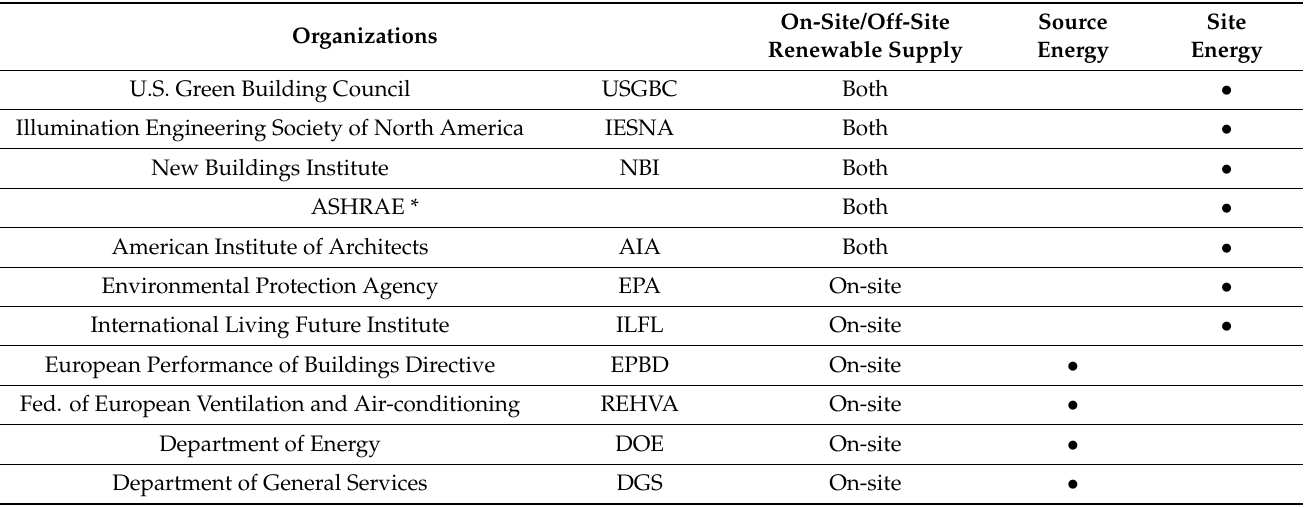
Table 3. Variations in NZ